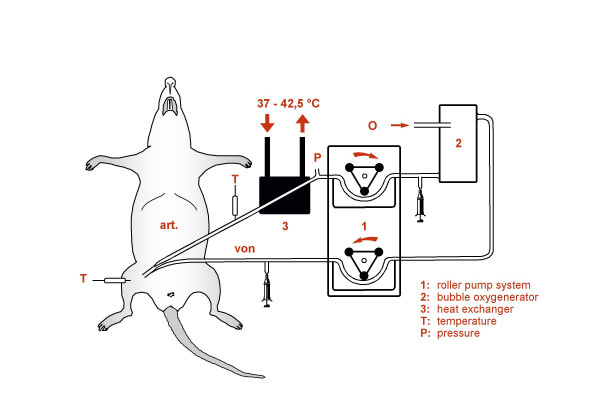
Diagrammatic outline of the experimental setup. 1: roller pump system; 2: bubble oxygenerator; 3: heat exchanger, T: temperature